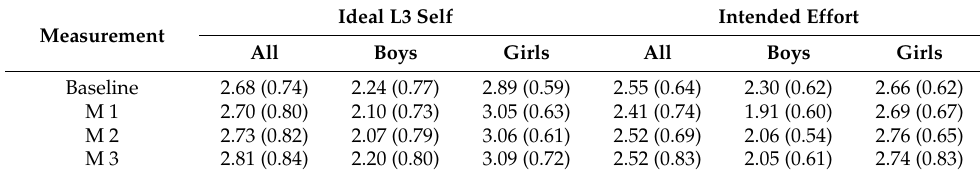
Table A2. Mean and SD of ideal L3 self and intended effort according to gender.